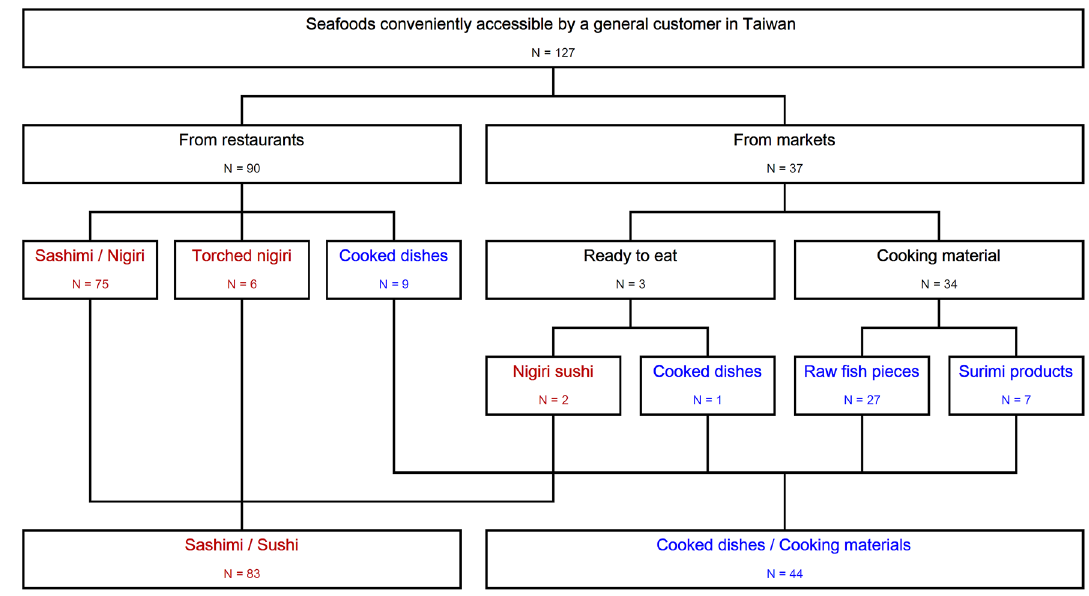
Figure 1. A schematic overview of the study. N: sample